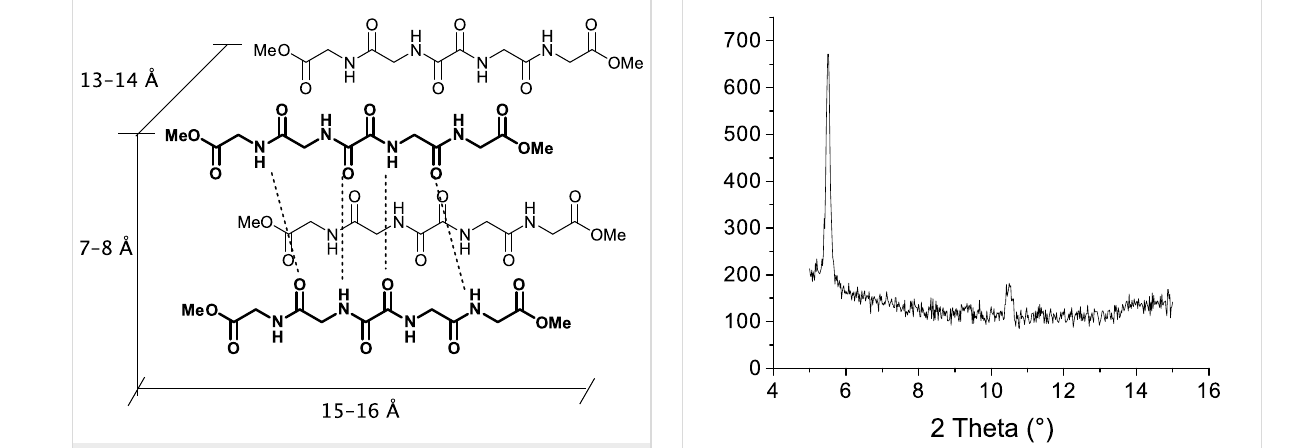
( S,S )- 1b and ( S,R )- 1b shown in Figure 10a, b. In both cases,